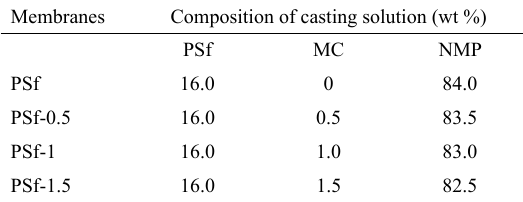
Table 1: The compositions of the PSf/MC/NMP casting